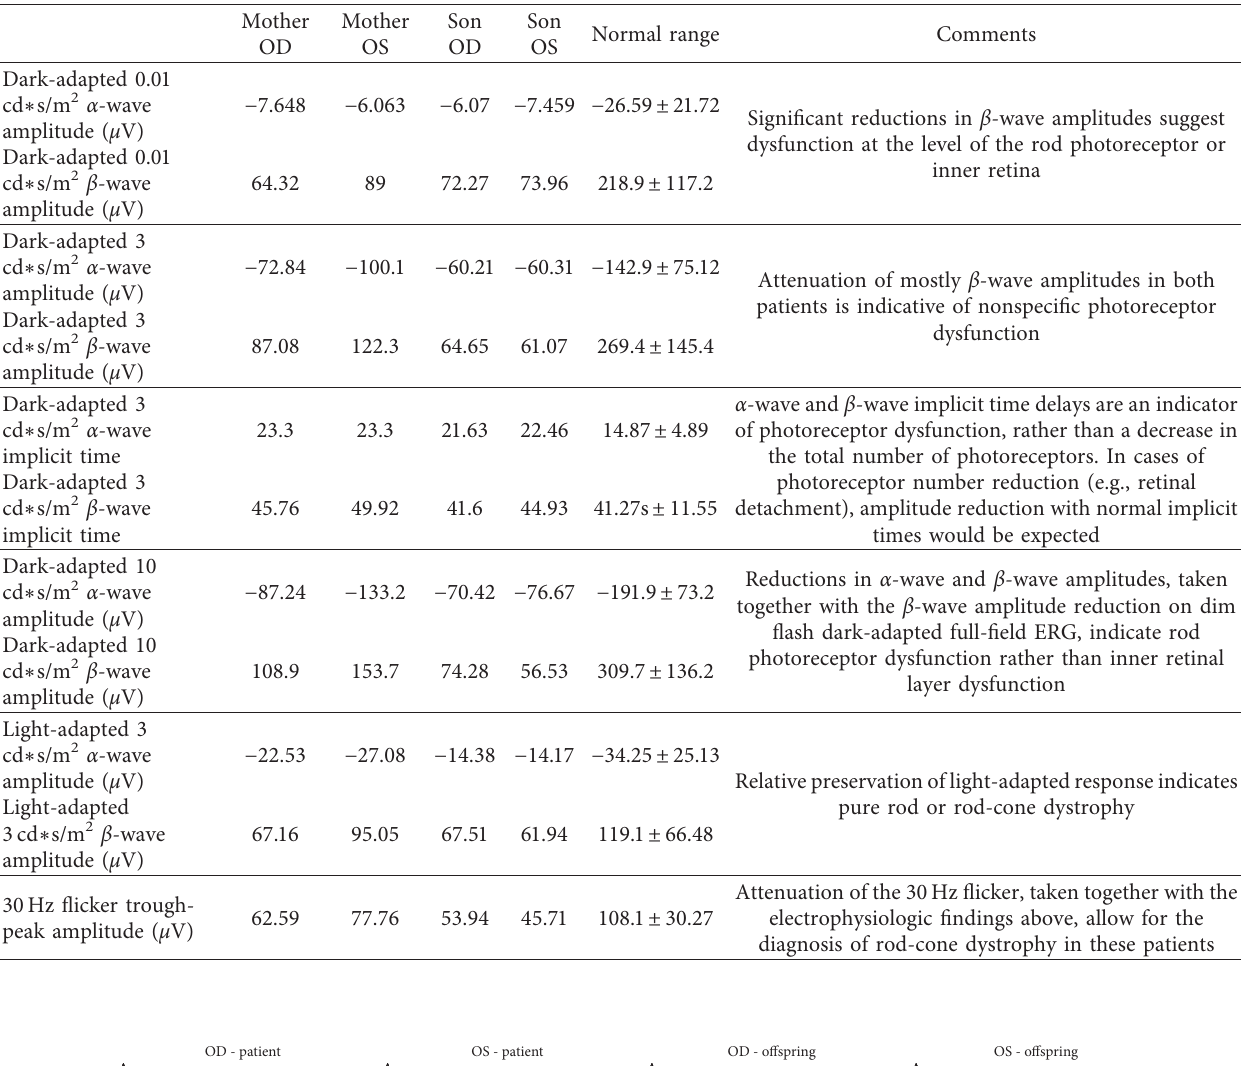
Table 1: Full-field electroretinography (ERG) findings in the proband (mother) and son, all performed as per the ISCEV (International Society for Clinical Electrophysiology of Vision) standard. Flash stimuli are given in units of candela-seconds per square meter, and normative data were obtained from Diagnosys